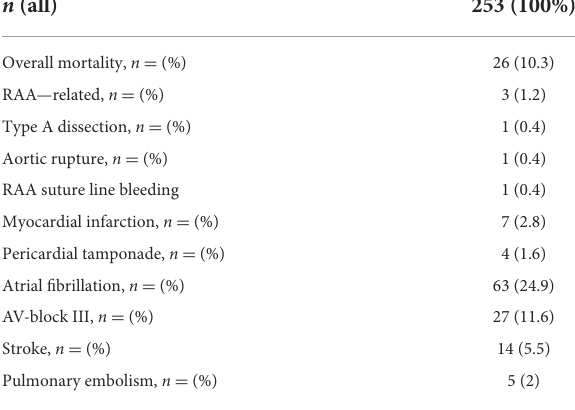
TABLE 2 Procedural and periprocedural characteristics. TABLE 4 Postoperative